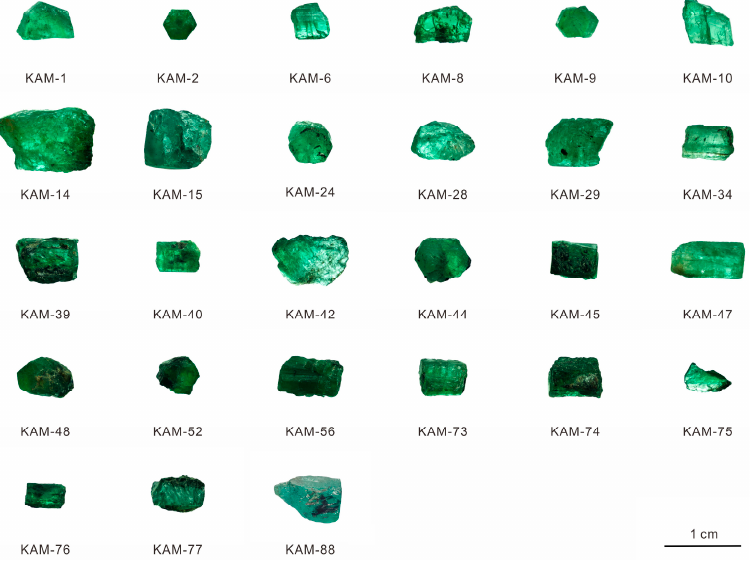
Figure 2. The 27 Kamakanga, Zambia, emerald samples for this